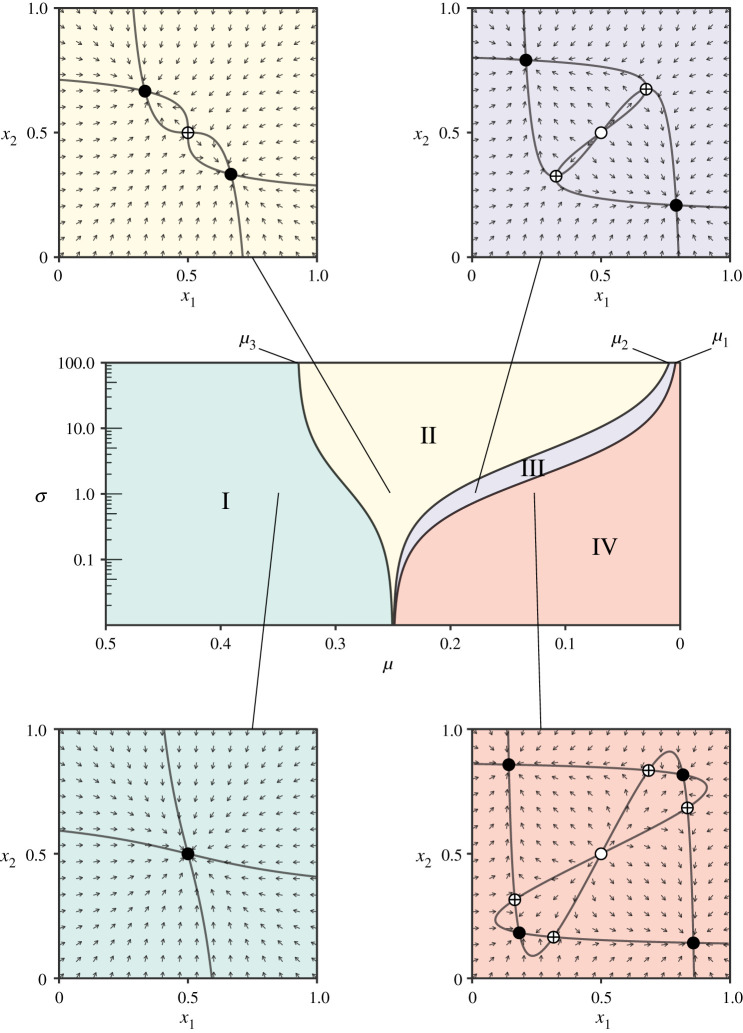
Bifurcation diagram of the fully symmetric two-strategy, two-population convergence–divergence game. The parameter space is divided into four phases, illustrated in the surrounding phase space plots for σ = 1 and the following values of μ: 0.35, 0.25, 0.18, 0.13 (filled circles: sinks; crossed circles: saddles; open circles: sources). The curves indicate nullclines, i.e. the sets where either x˙1=0 or x˙2=0.